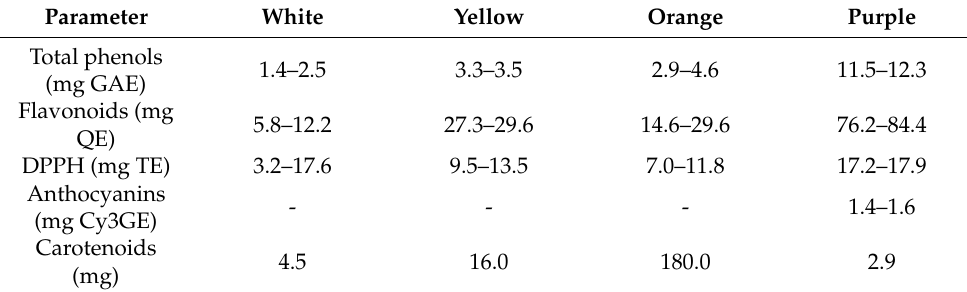
Table 3. Antioxidant phytochemicals reported in SP ( Ipomoea batatas L.) 1 . Parameter White Yellow Orange Purple Total